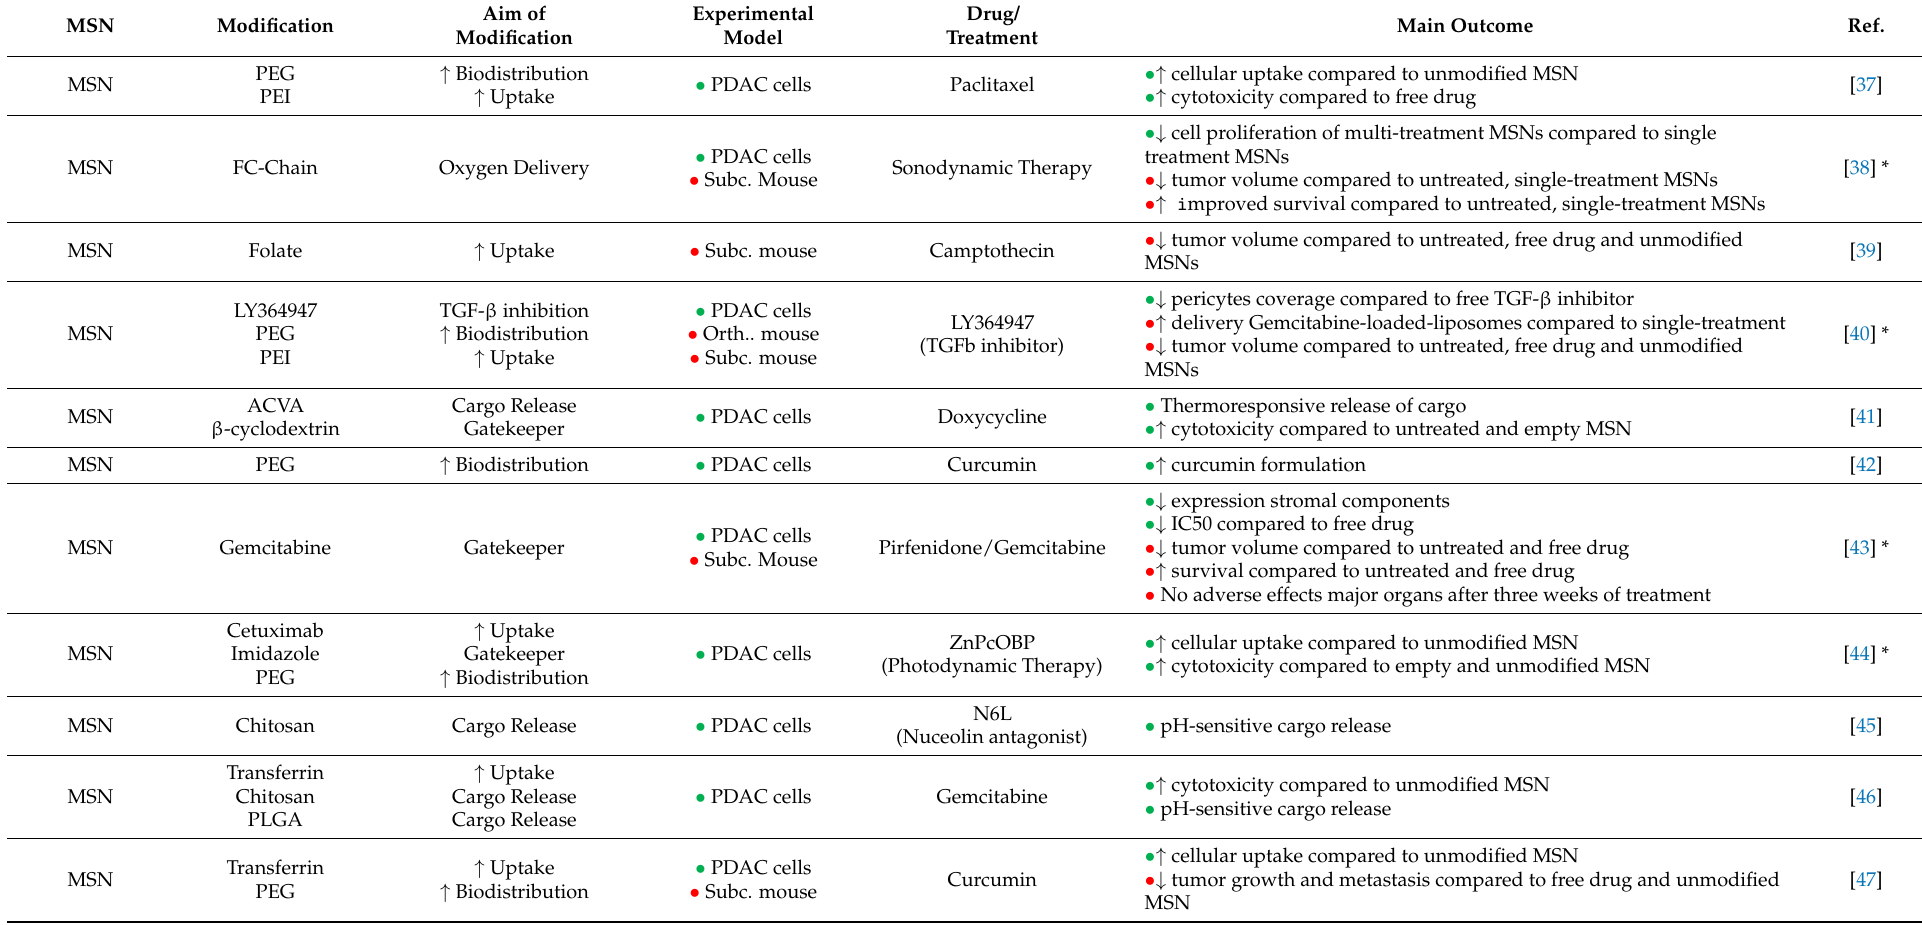
Table 1. MSN-based Therapies for Improved Drug Delivery in